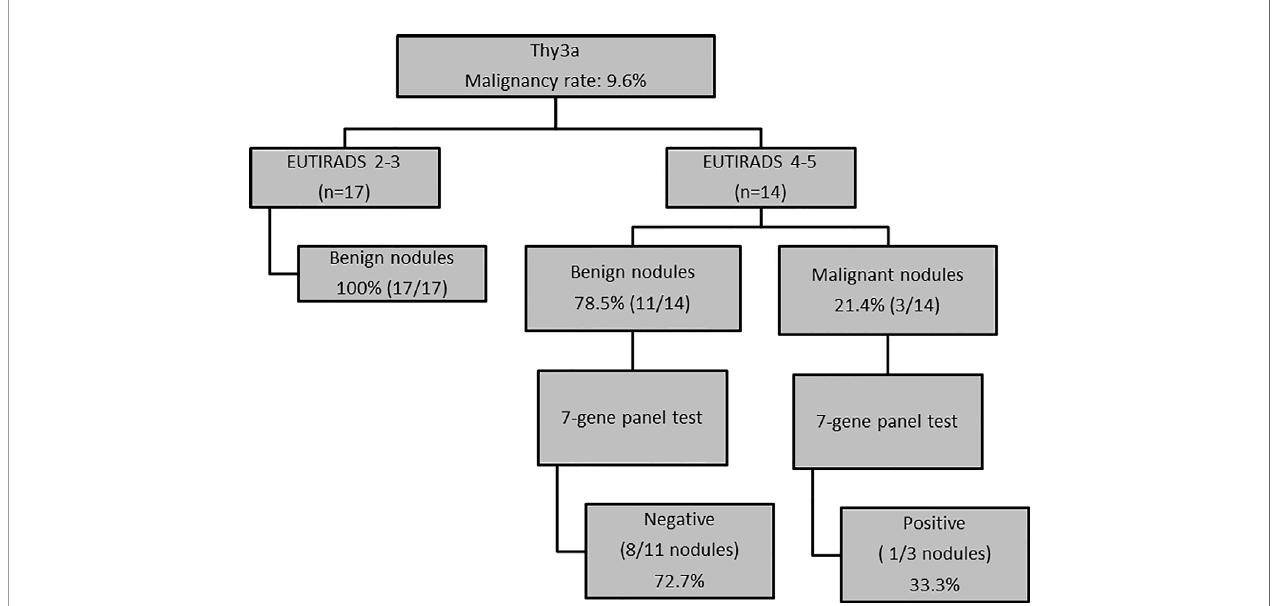
FIGURE 2 | US and molecular features as criteria for decision-making in TIR3A nodules (n = 31